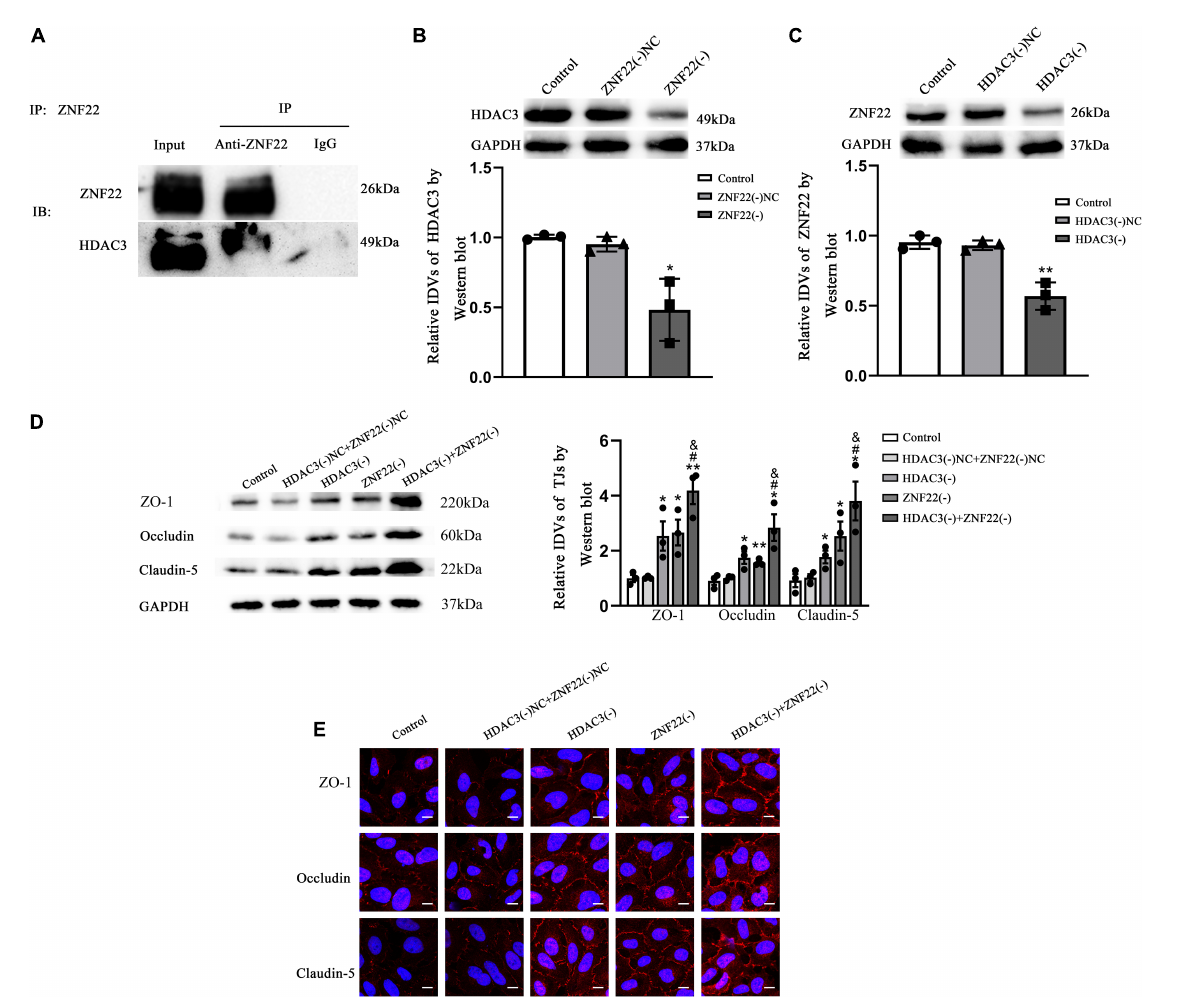
FIGURE5 ZNF22 interacted with HDAC3 to block the expression of TJ-associated proteins, which led to activating BTB permeability. (A) Interaction between endogenous ZNF22 and HDAC3 was detected by immunoprecipitation in GECs. (B) Protein blot analysis of HDAC3 expression in GECs. As an endogenous control, GAPDH protein levels were measured. Data were expressed as mean ± SD ( n = 3, each). * p < 0.05 vs. ZNF22(–) NC group. (C) Protein blot analysis of ZNF22 expression in GECs. As an endogenous control, GAPDH protein levels were measured. Data represent mean ± SD ( n = 3, each). ** p < 0.01 vs. ZNF22(–) NC group. (D) In GECs, protein blot analysis revealed the expression of TJ-associated proteins ZO-1, Occludin, and Claudin-5. As an endogenous control, GAPDH protein levels were measured. The data is presented as mean ± SD ( n = 3, each). * p < 0.05 and ** p < 0.01 vs. HDAC3(–) NC + ZNF22(–) NC group. # p < 0.05 vs. HDAC3(–) group. & p < 0.05 vs. ZNF22(–) group. (E) ZO-1, Occludin, and Claudin-5 immunofluorescence localization in GECs. Fluorescent secondary antibodies were used to label ZO-1 (red), Occludin (red), and Claudin-5 (red), while DAPI was used to label nuclei. The photos were taken from three separate trials. Scale bar = 20 µ